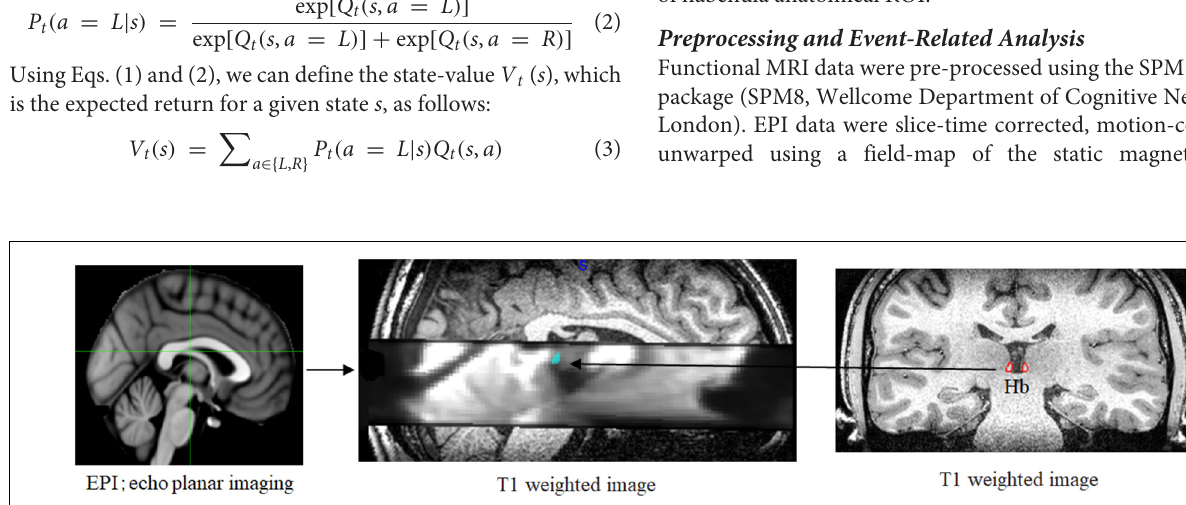
FIGURE 2 | Example of individual data. The T1 structural images to enable localization of the habenula and echo-planar imaging (EPI) were co-registered to their whole-brain anatomical scans, respectively.